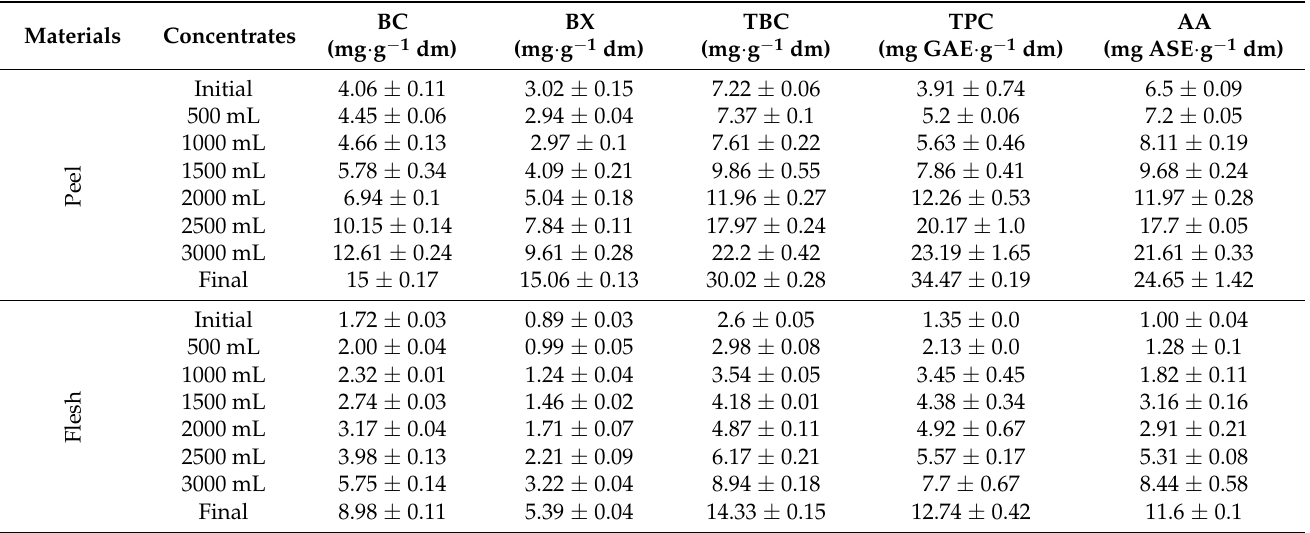
Table 1. Betalains, TPC, and antioxidant contents in initial and retentate beetroot peel and flesh extracts.